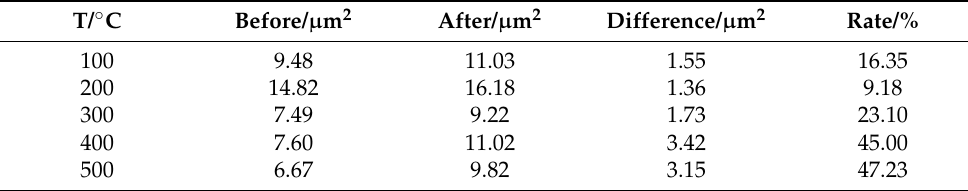
Table 1. Change of shale fracture area before and after Sc-CO2